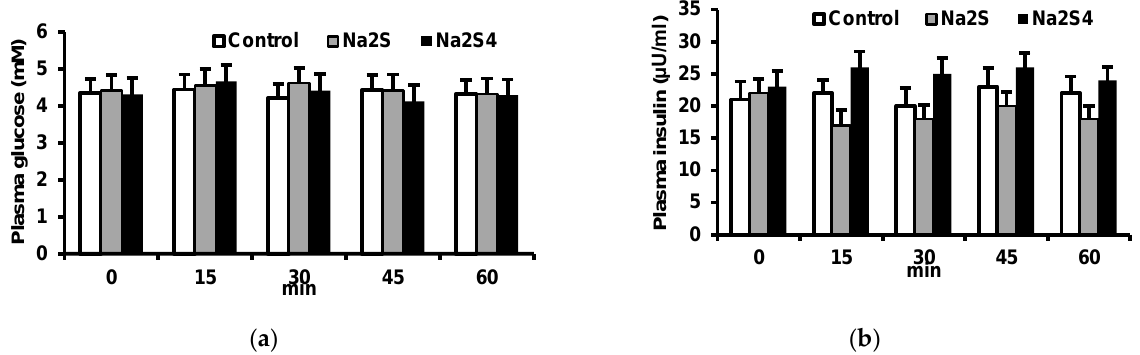
Figure 1. Effect of Na 2 S and Na 2 S 4 on plasma glucose ( a ) and insulin ( b ) concentrations. Na 2 S or Na 2 S 4 were injected intravenously and blood samples were collected before as well as 15, 30, 45, and 60 min after injection.